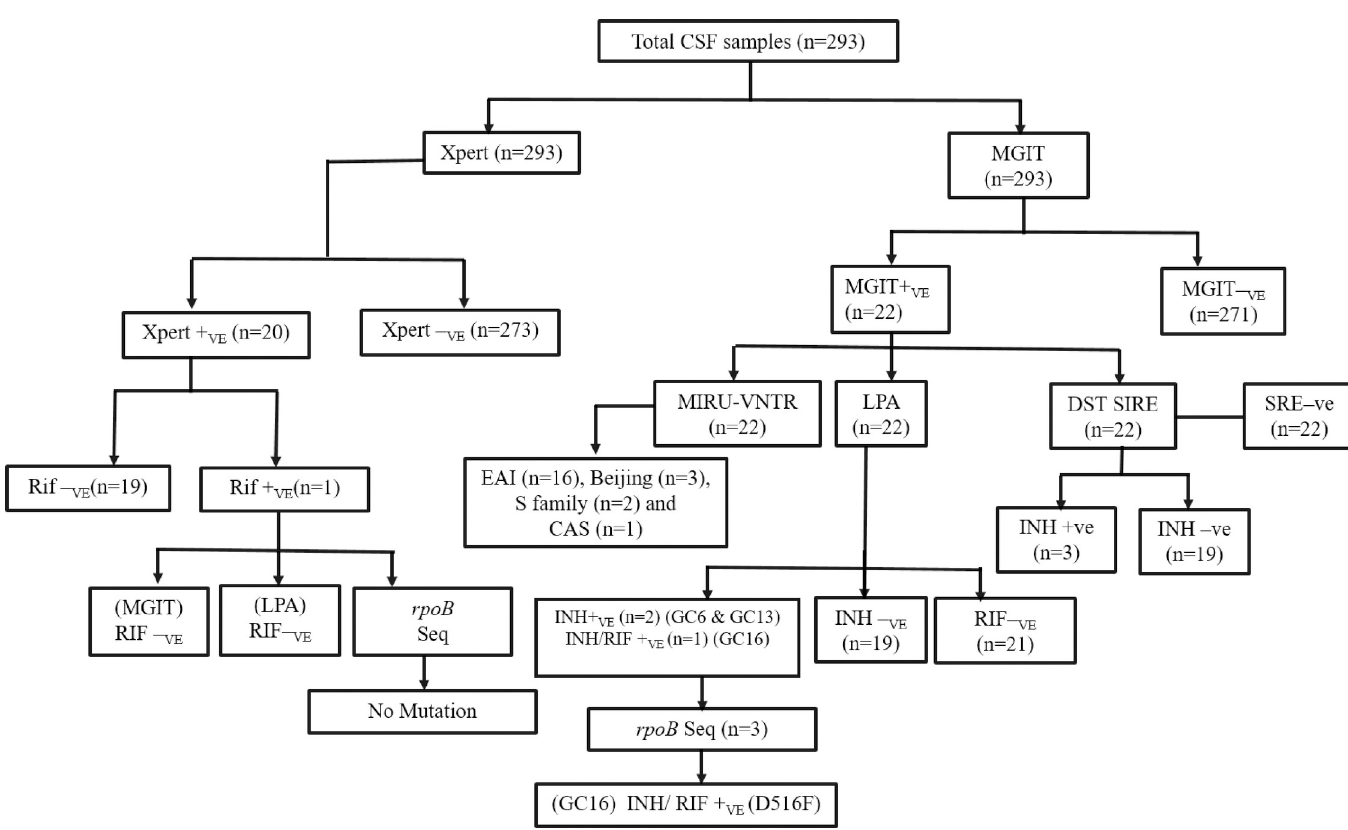
Fig 1. Diagnostic algorithm of the study. Xpert—GeneXpert; MGIT—MGIT 960; +ve—Positive;–ve—Negative; S—streptomycin; I—isoniazid; R—rifampicin and E— ethambutol.